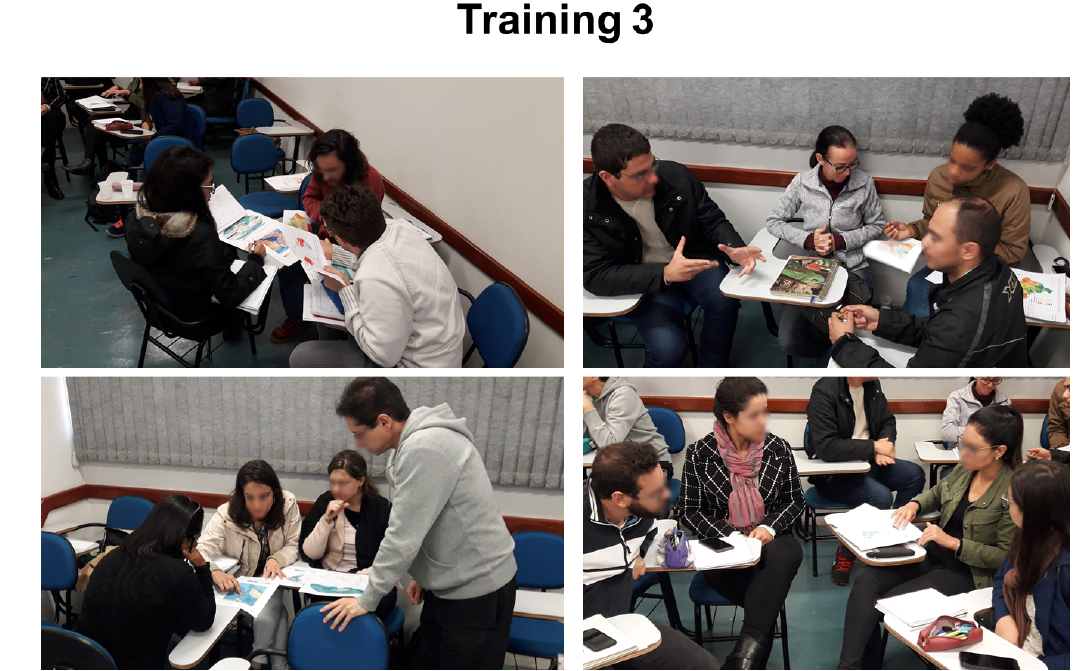
Figure A15. Photos of the groups working on the activities of the third training.